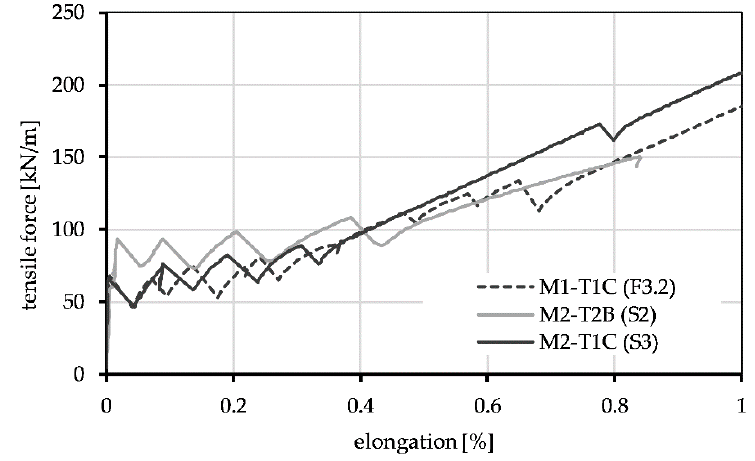
Figure 10. Exemplary tensile force elongation curves of the material combinations. Single curves; free length: 300 mm; measuring length: 250 mm; testing velocity: 1.0 mm/min.